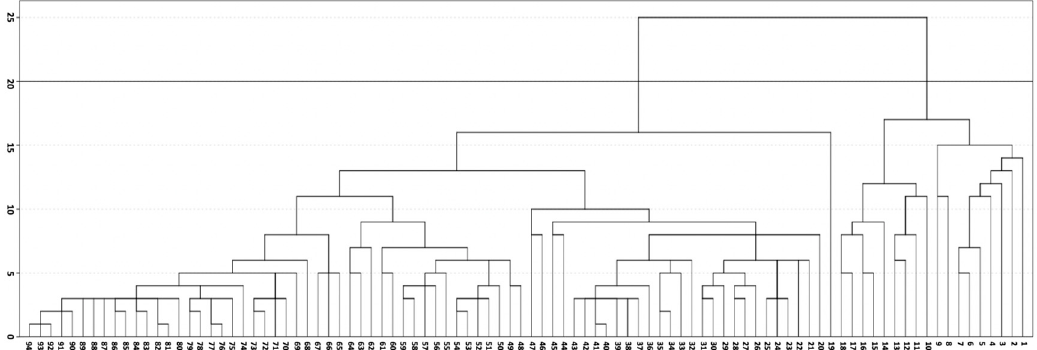
Figure 1. Dendrogram showing the hierarchical classification of patients. The x -axis represents the grouped objects; the y -axis is the cluster proximity.